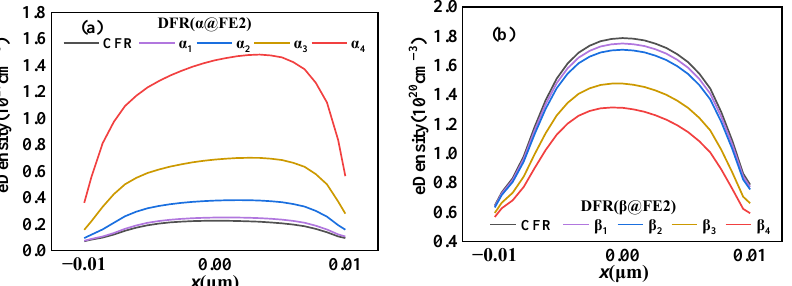
Figure 5. Electron concentration distribution on the channel surface of the CFR-NCFET and DFR- NCFET, ( a ) variable α in FE2 region, ( b ) variable β in FE2 region.